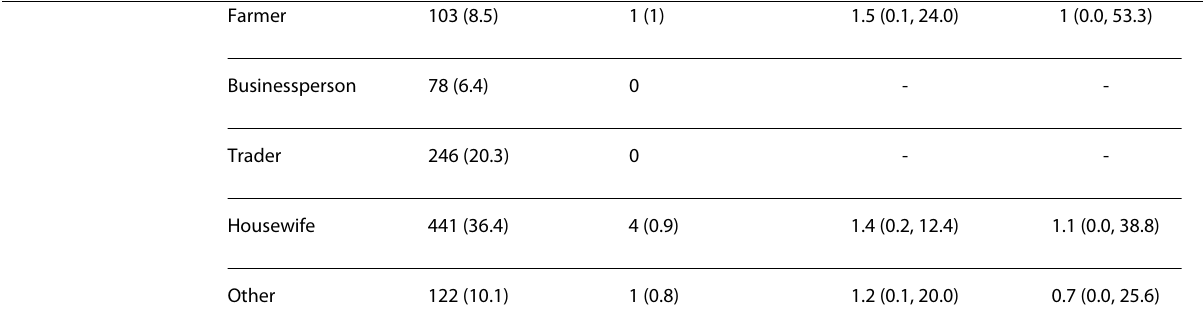
Table 1: Antenatal population: Characteristics and unadjusted and adjusted OR for HIV